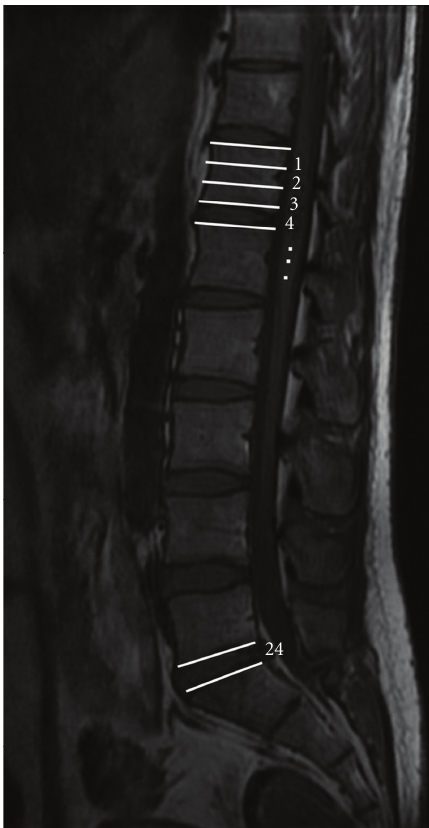
Figure 1: Mid-sagittal T1-weighted MRI of lumbosacral spine. Each vertebra is divided into 3 equal parts of upper, middle, and lower segments. Vertebral segments and disc spaces were numbered consecutively from T12 upper segment downward to L5S1 intervertebral